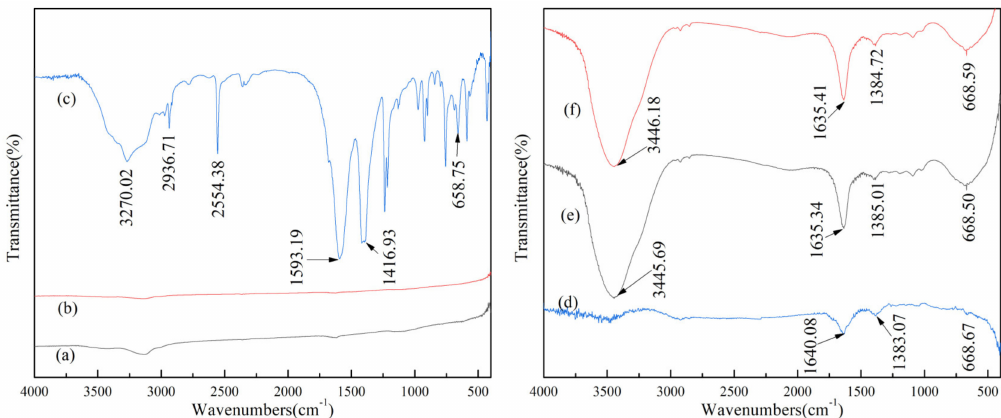
Figure 8. The FTIR spectra of chalcopyrite ( a ), chalcopyrite + CuSO 4 ( b ), STG ( c ), di ff erence spectrum ( d ), chalcopyrite + STG ( e ), and chalcopyrite + CuSO 4 + STG ( f ); c(CuSO 4 ) = 1 × 10 − 3 mol / L, c(STG) = 1.5 × 10 − 3 mol /